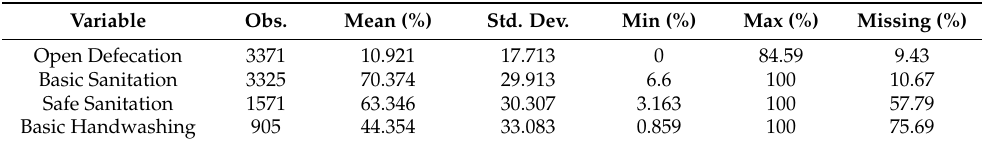
Table 1. Descriptive